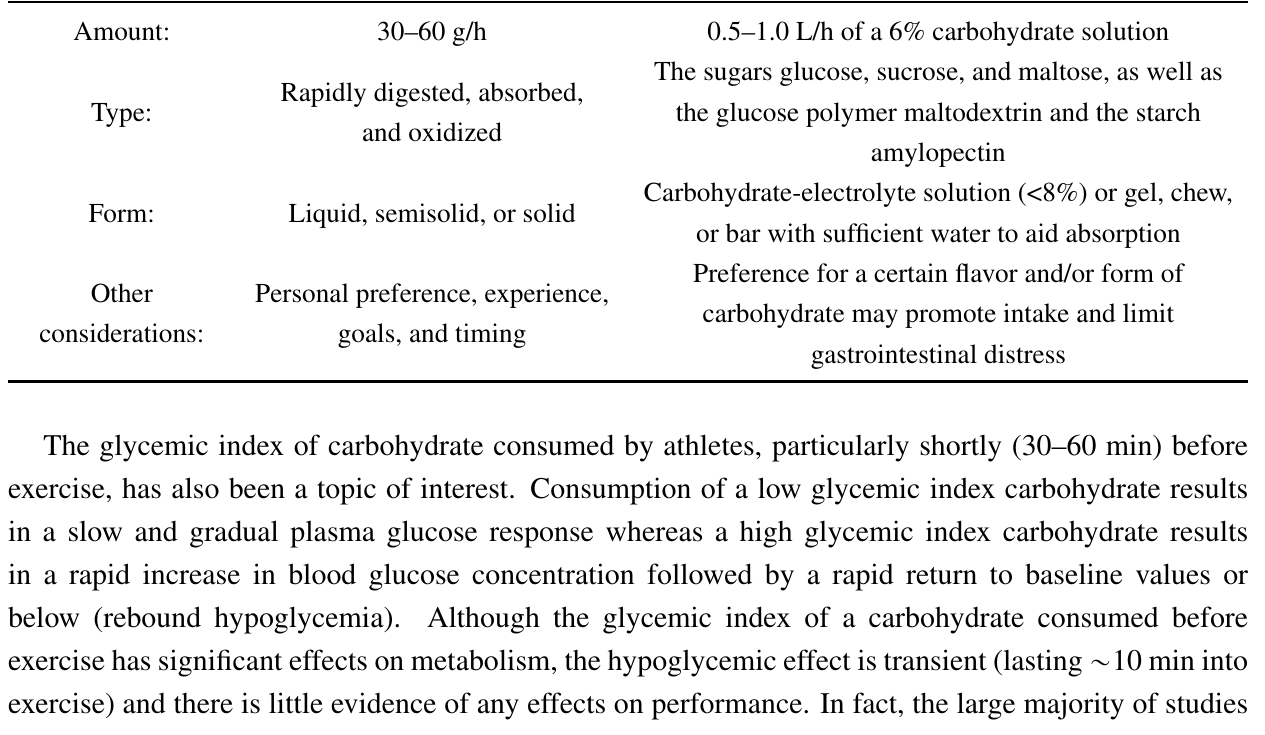
Table 3. Considerations for carbohydrate ingestion during intermittent sports.